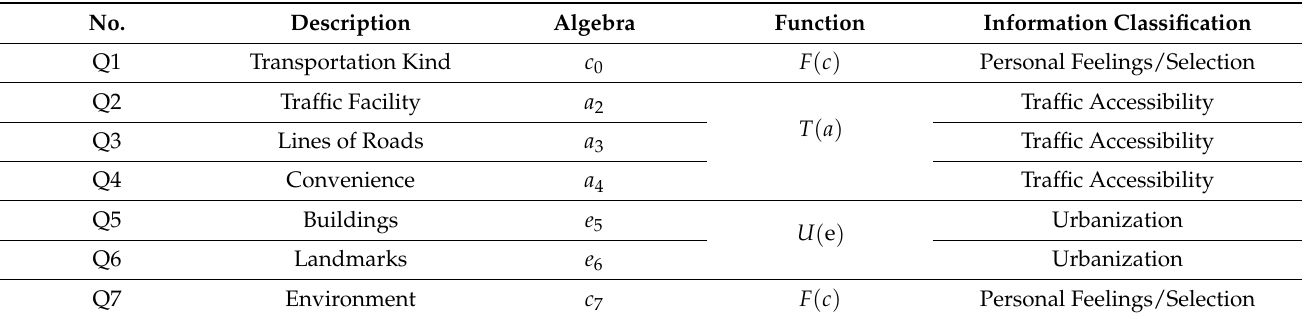
Table 3. Functional definitions of questionnaire answers. Briefly, the questionnaire answers are converted into algebra and